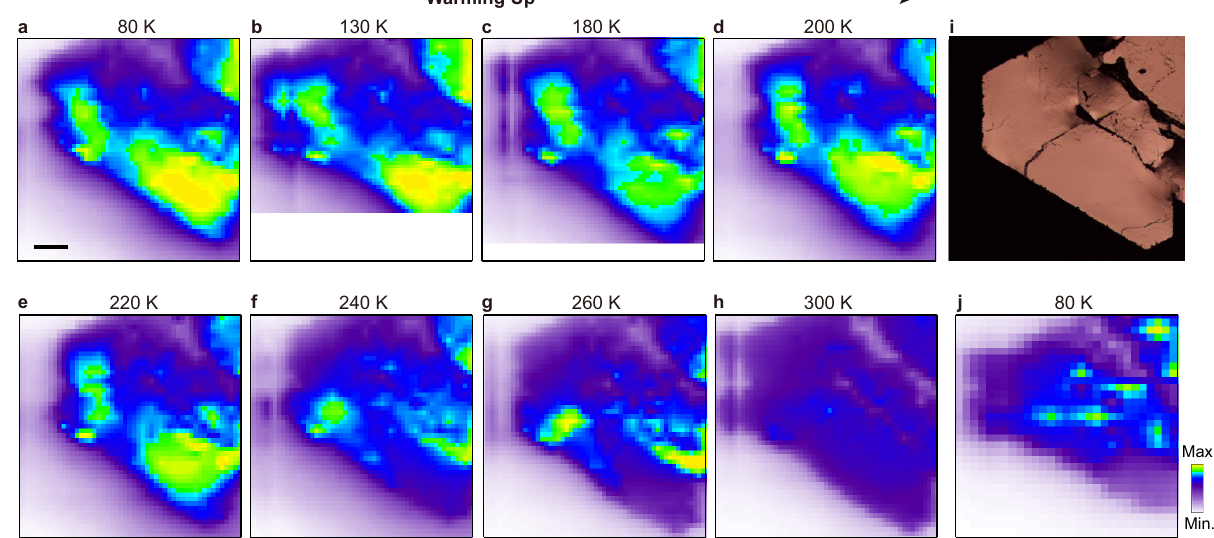
Fig. 3 Electronic reconstructions of 1/6 and 1/3 revealed by NanoARPES and MicroARPES. a , b Fine Fermi surface maps measured by NanoARPES. Guides for the pockets (solid curves) and replicas (dotted curves) translated by q 1/3 and q 1/6 are overplotted in b . c – f Dispersion images ( c , e ) along the direction as indicated in a and corresponding momentum distribution curves (MDC) ( d , f ). g High-resolution zoom-in Fermi surface map by MicroARPES. h Spatially resolved intensity map by integrating over momentum range of k y = ( − 0.1 Å − 1 , 0.1 Å − 1 ) and energy range of E = ( − 0.05 eV, 0). i , j NanoARPES ( i ) and MicroARPES ( j ) dispersion images along the directions as indicated in b . The white curves are extracted dispersions from MicroARPES spectrum ( j ) and overplotted to NanoARPES spectrum in i . k Zoom-in Fermi surface map by MicroARPES. Solid curves are guides for the pockets and dotted curves are the replicas translated by q 1/6 . l , m Dispersion images ( l ) along the direction as indicated in k and corresponding MDCs ( m ).